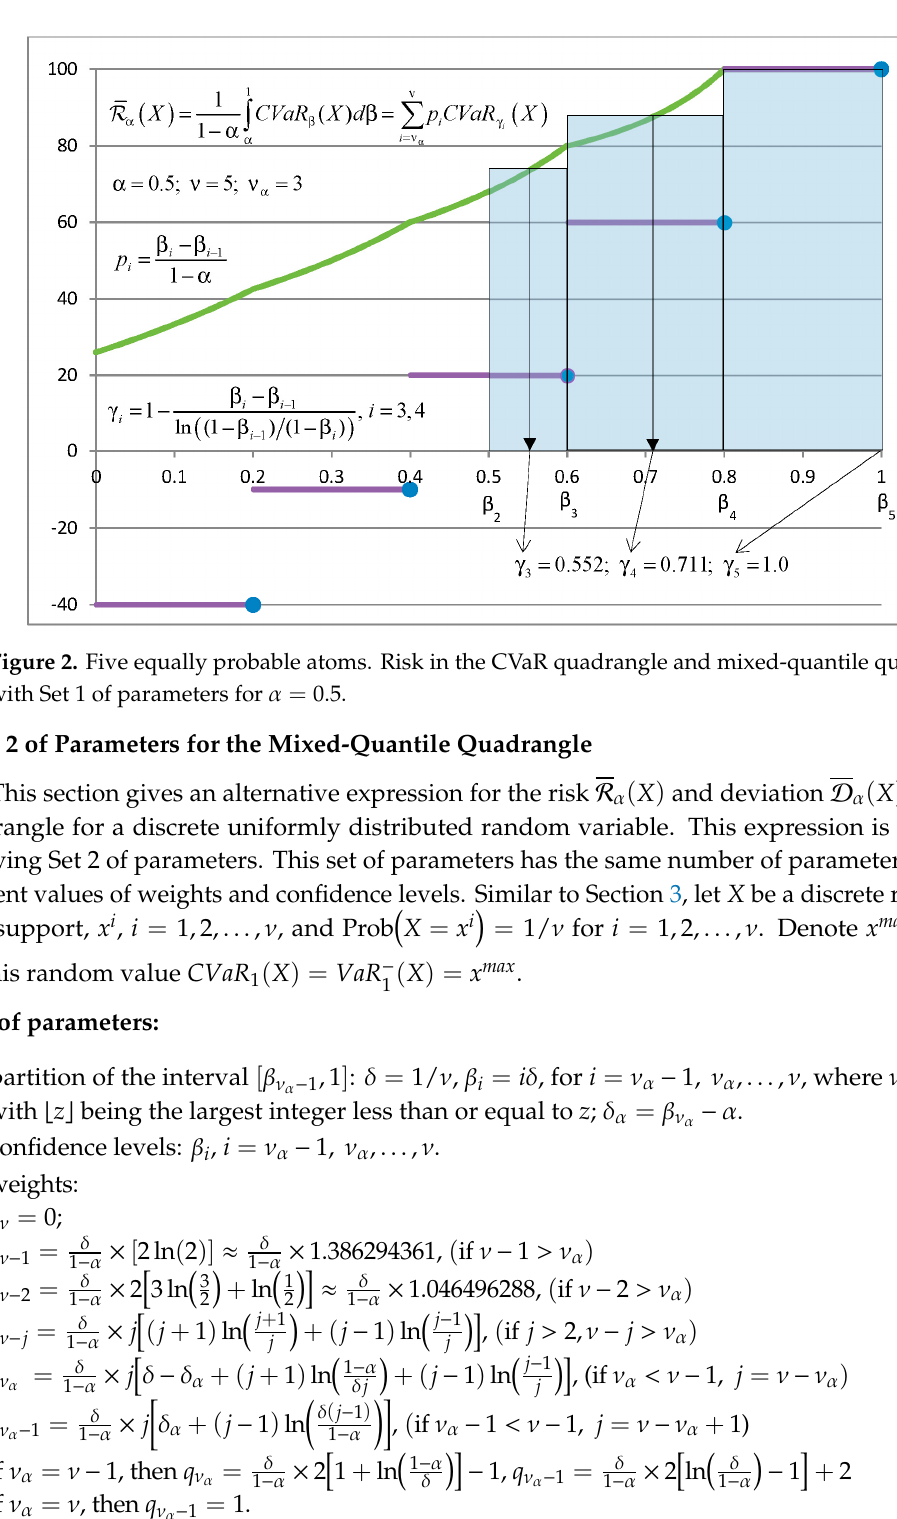
Figure 1. Five equally probable atoms. VaR and CVaR with Set 1 of parameters for 𝛼 = 0.5.